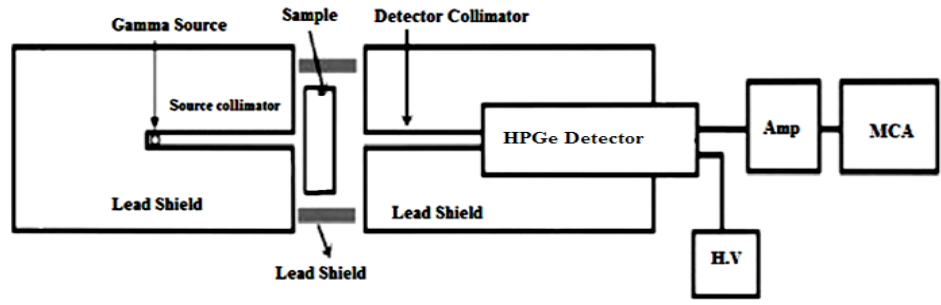
Figure 1. The schematic diagram of the experimental setup for the narrow-beam method.